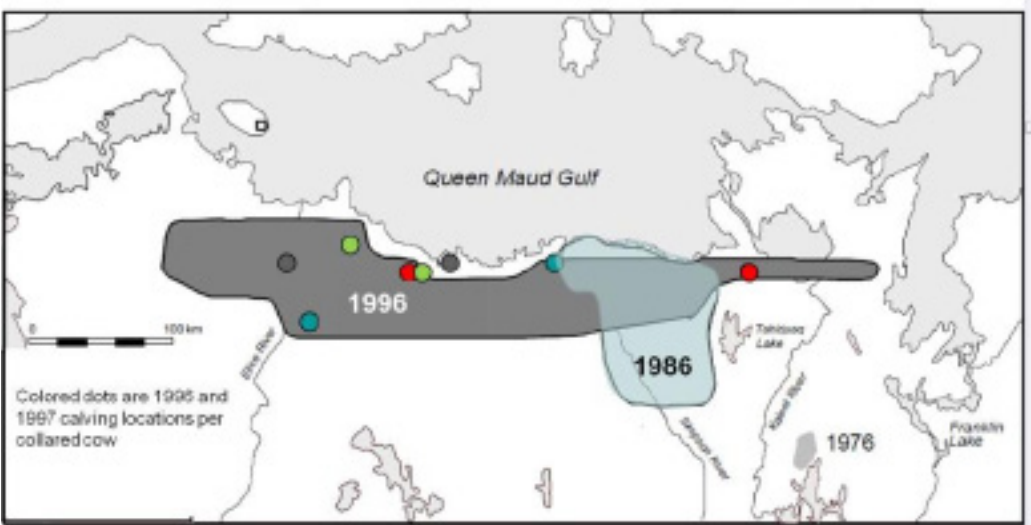
Fig. 3. The approximate extent of the Ahiak herd’s calving distribution in June 1986 and 1996 (Gunn et al., 2000), and 1996–97 calving locations from collared